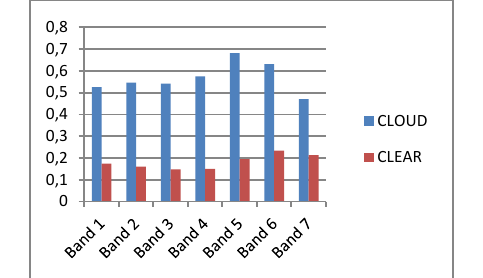
Figure 2. The difference of reflectance values between clear pixels and cloud contaminated pixels on settlement.